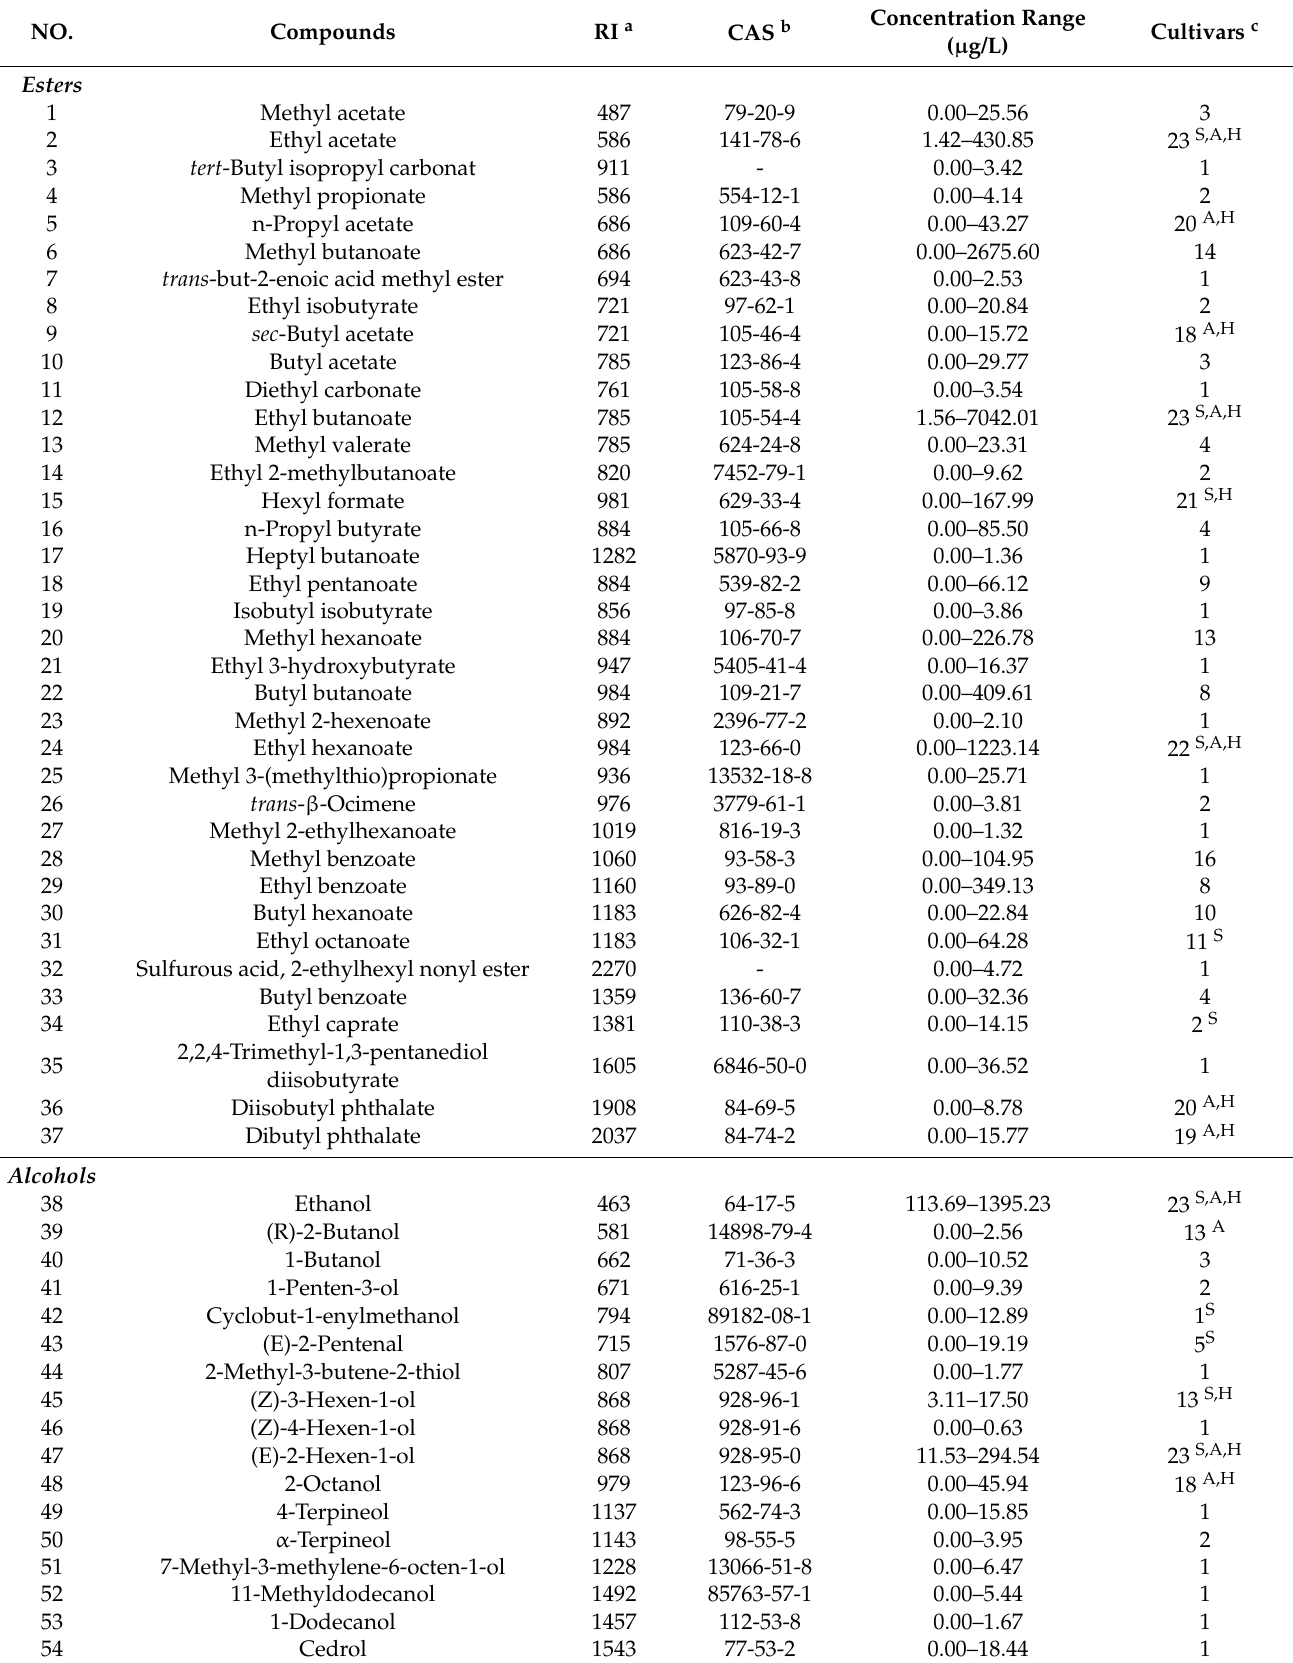
Table 2. The volatile components in kiwifruit and their basic parameters and concentration